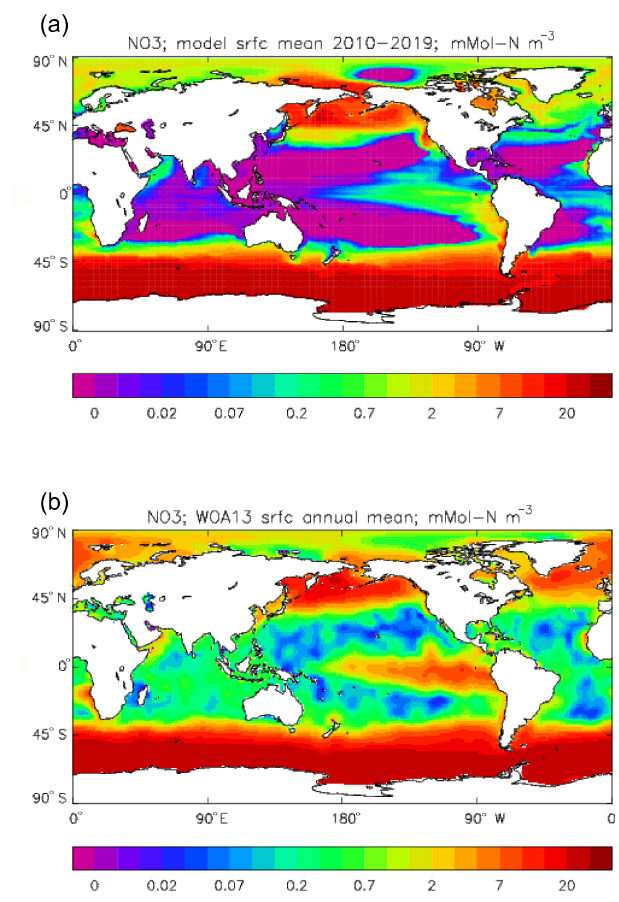
Figure 22. Surface dissolved nitrate (mMolNm − 3 ): (a) model field averaged over model years 2010–2019; (b) the gridded field from the 2013 World Ocean